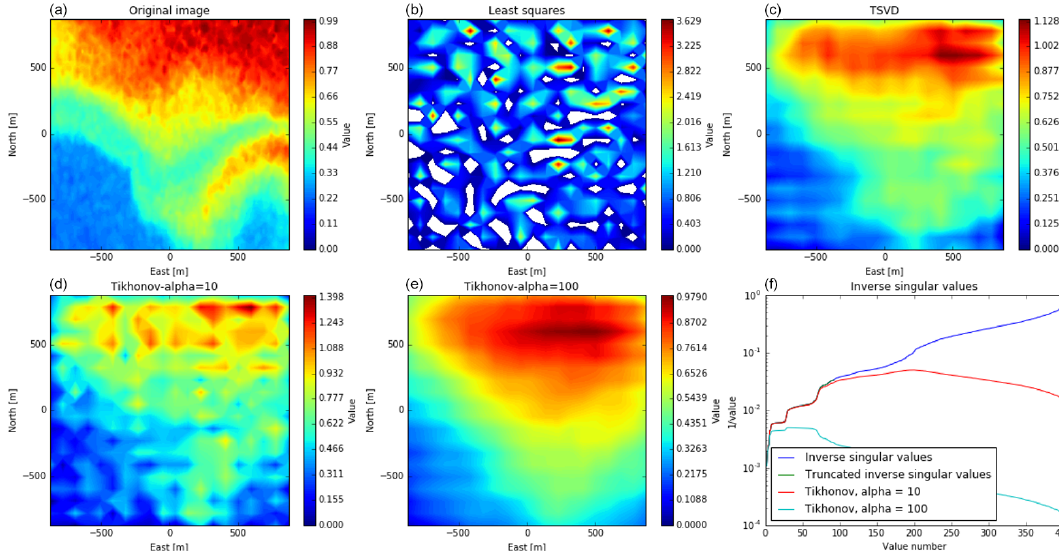
Figure 10. Comparison of reconstructions, using SVD for the SIMO case, including the outriggers. The plots correspond to Fig. 9.